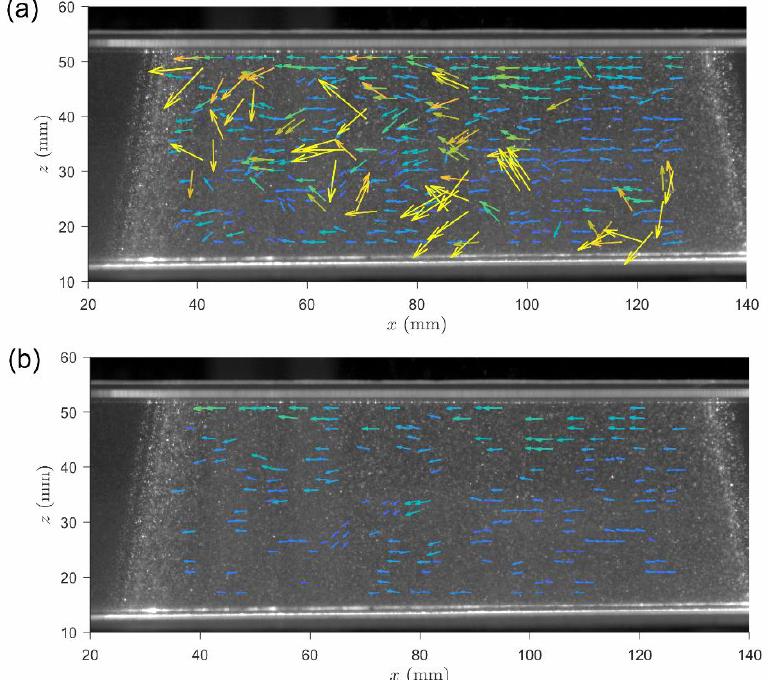
Figure 10. Randomly selected ( a ) raw and ( b ) filtered velocity maps corresponding to the 2nd peaks in the cross-correlation results derived from case PIVB.